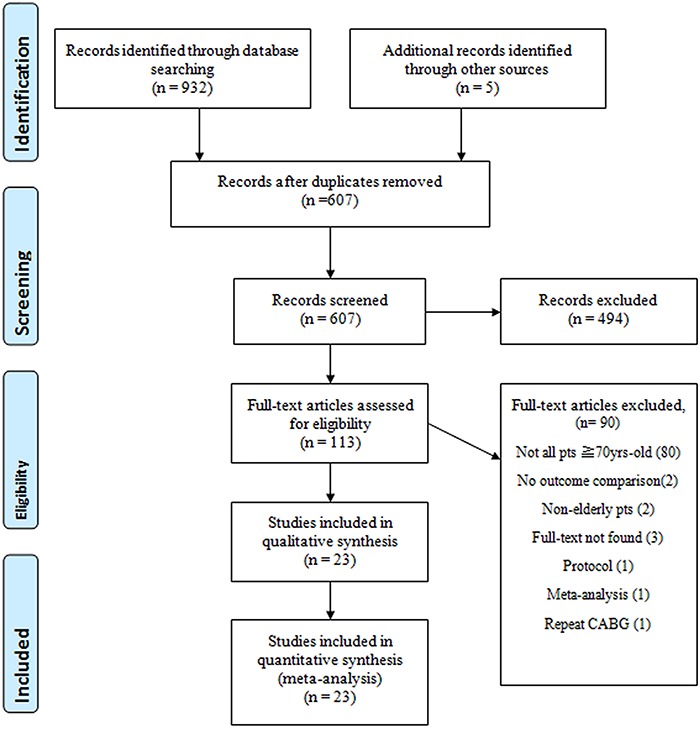
PRISMA flow diagram.